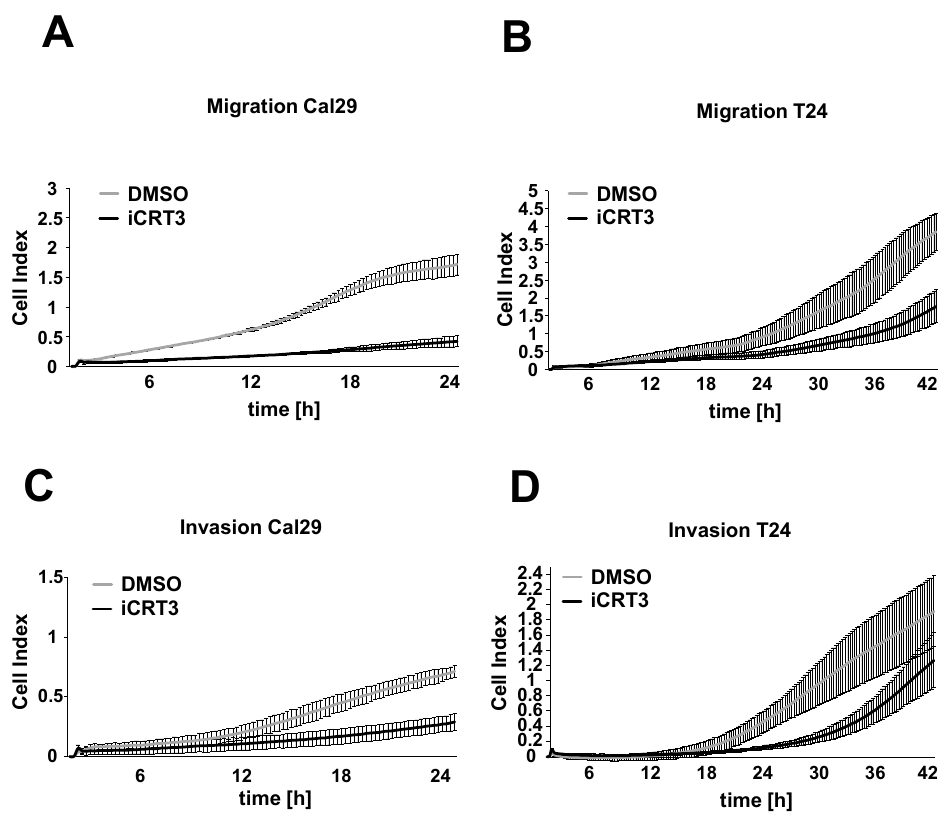
Figure 8. Cell migration and invasion analysis after Wnt/β-catenin signalling inhibition in bladder cancer cells. Treated Cal29 ( A ) and T24 ( B ) cells with 40 µM iCRT3 and 0.1% DMSO were seeded on CIM plates and migration was analysed in real-time by the xCELLigence system. Treated Cal29 ( C ) and T24 ( D ) cells were seeded in the pre-coated CIM plate with matrigel and the invasion was analysed. The figure represents one of the biological replicates. All three independent biological replicates are shown in Supplementary Figure S7. The data are expressed as mean ± standard deviation of three technical replicates. The cell index values correspond to the cell number that migrates or invades.